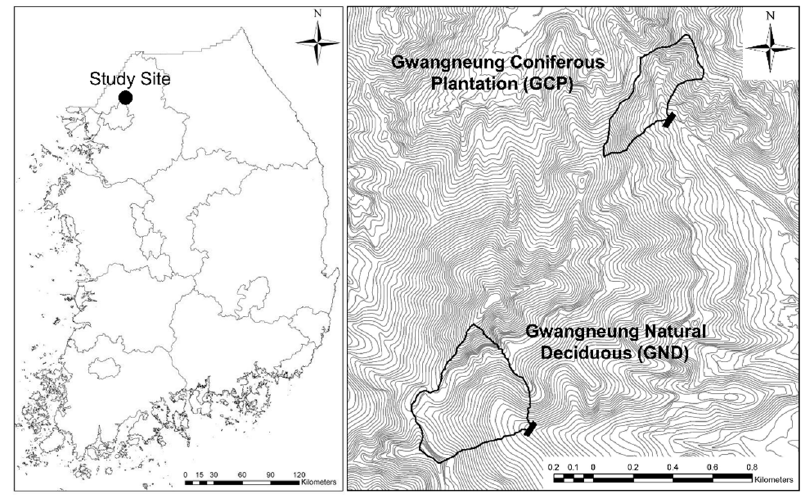
Figure 1. Location of the study sites: the Gwangneung coniferous plantation (GCP) and natural deciduous (GND) forest catchments.